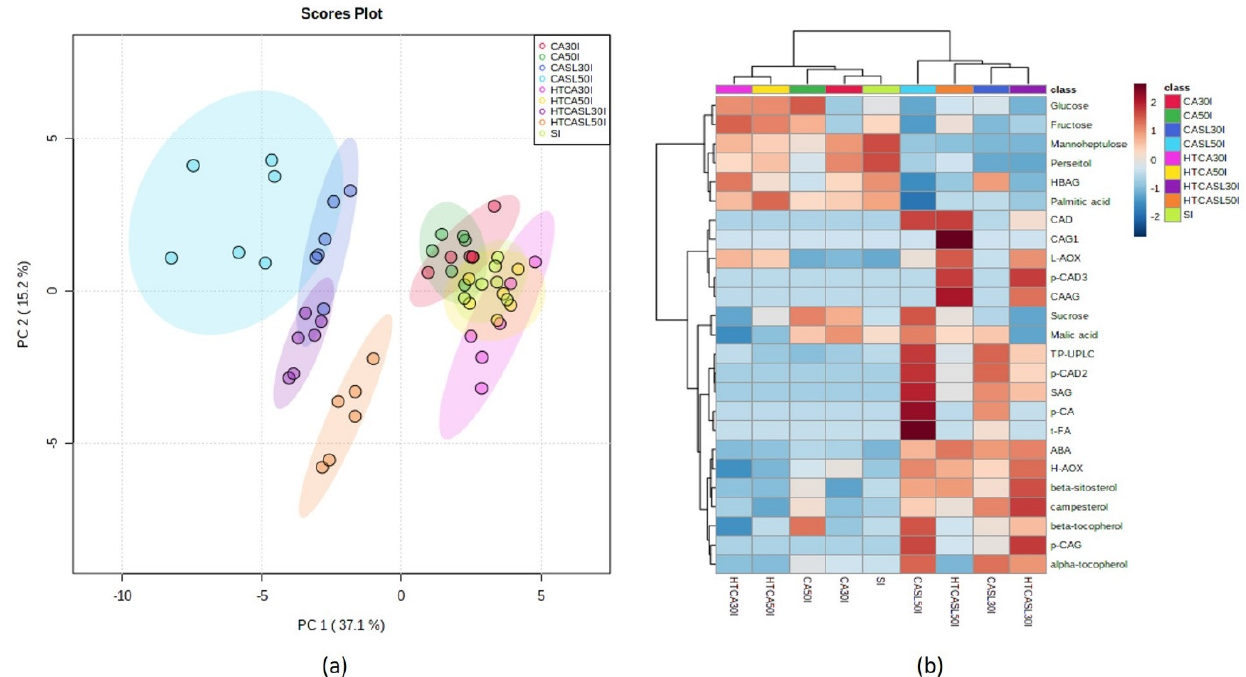
Figure 2. Principal component analysis of early harvest dataset. (a) Score plot and (b) heat map based on hierarchical cluster analysis based on Euclidean distance and Ward algorithm with the 25 significant metabolites revealed by ANOVA followed by the Tukey test ( p < 0.05). Samples correspond to different treatments, storage times, and corresponding edible ripeness stages. Samples corresponding to the different conditions are on the horizontal axis, and the abundance of the different metabolites and analysis are represented on the vertical axis. SI = Initial day early harvest; CA30I and CA50I = controlled atmosphere for 30 and 50 days early harvest; CASL30I and CASL50I = controlled atmosphere for 30 and 50 days early harvest after shelf-life period; HTCA30I and HTCA50I = hydrothermal treatment for 30 and 50 days early harvest; HTCASL30I and HTCASL50I = hydrothermal treatment for 30 and 50 days early harvest after shelf-life period. The average of the 6 replicates is displayed. DM = dry matter, ABA = abscisic acid, H-AOX = hydrophilic antioxidant activity, L-AOX = lipophilic antioxidant activity, DHBAG = dihydroxybenzoic acid glycoside, SAG = syringic acid glycoside, CAG1 = caffeic acid glycoside 1, CAG2 = caffeic acid glycoside 2, HBAG = hydroxybenzoic acid glycoside, p -CAG = p -Coumaric acid glycoside, CAD = caffeic acid derivative, p -CAD1 = p -coumaric acid derivative, CAAG = caffeic acid acetilglycoside, p -CA = p -coumaric acid, p -CAAG = p -coumaric acid acetylglycoside, p -CAD2 = p -coumaric acid derivative, t -FA = trans-ferulic acid, p -CAD3 = p -coumaric acid derivative.